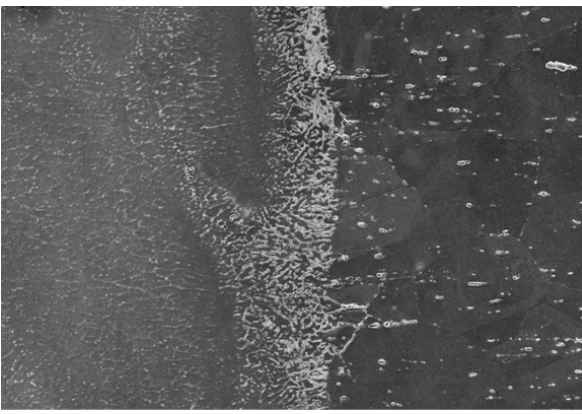
Figure 8: Structure of weld and HAZ of 316L steel